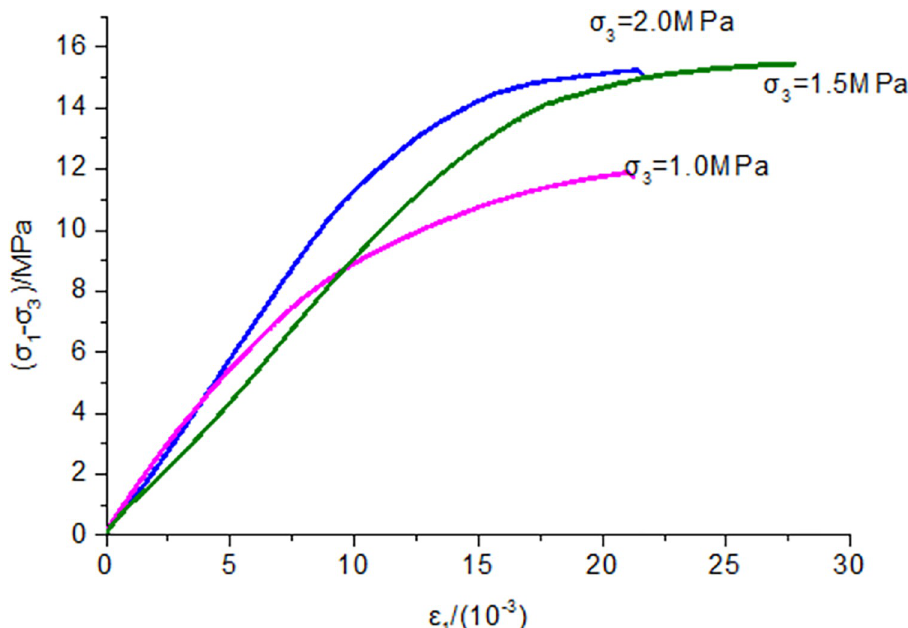
Fig 13. Triaxial compression stress-strain curve for the sealing